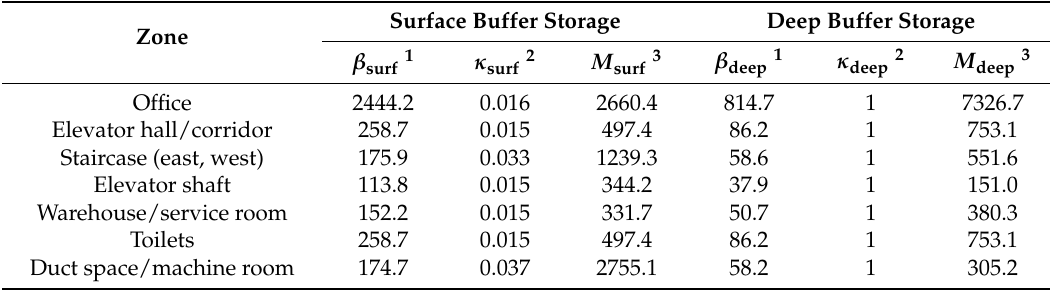
Table 10. Parameters setup of the Buffer Storage Humidity Model for a standard